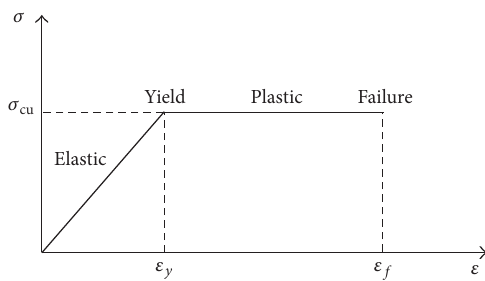
Figure 1: The ideal elastic-plastic stress-strain